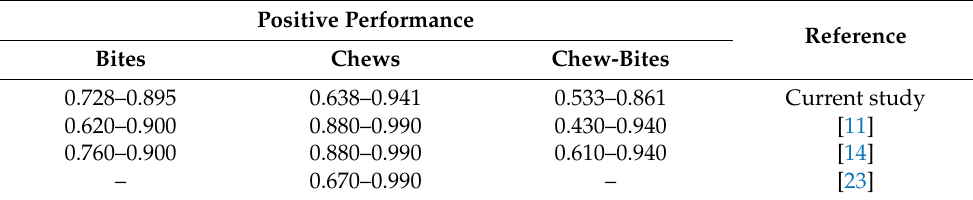
Table 5. Performance comparison for classifying bites, chews, and chew-bites of dairy cows among different